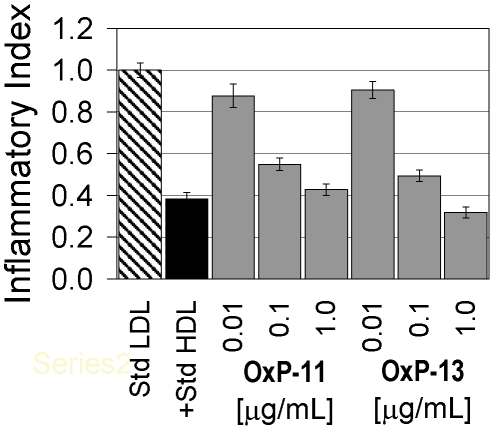
Dose response experiments.OxP-11 and OxP-13, the two most active oxpholipins in the monocyte chemotaxis assay were re-tested at three concentrations: 1 µg/ml, 0.1 µg/ml and 0.01 µg/ml. A 10-fold reduction, from 1.0 to 0.1 µg/ml caused a relatively small decrease in activity, but a 100-fold reduction to 10 ng/ml reduced activity substantially.